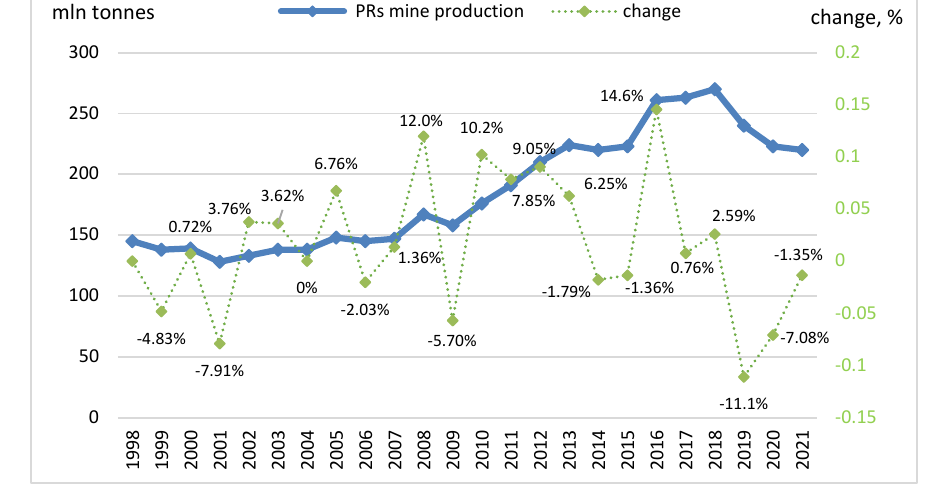
Figure 1. World phosphate rock production in 1998–2021 [4].